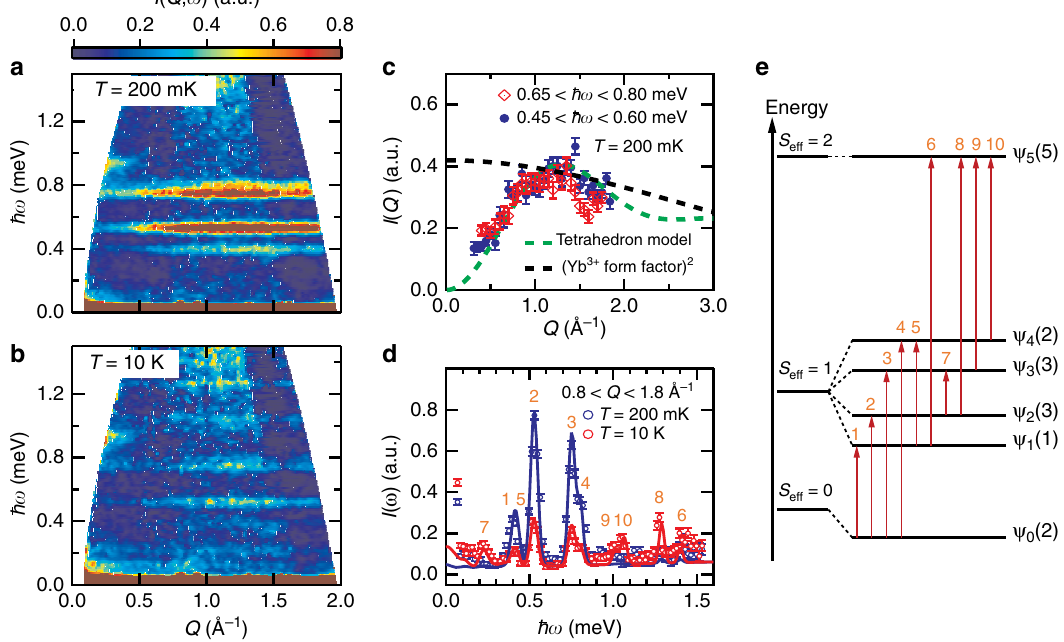
Figure 2 | INS results and an energy diagram of a Yb 4 molecular tetrahedron. ( a , b ) INS intensities I ( Q, o ) as a function of momentum Q and energy transfer : o measured using incident neutron energy E ¼ 2.27meV ( ¼ 6.0Å) at ( a ) T ¼ 200mK and ( b ) T ¼ 10K. ( c ) Constant- o cuts I ( Q )’s obtained by integrating over ranges of 0.45meV o : o o 0.60meV (blue filled circle) and 0.65meV o : o o 0.80meV (diamond) at 200mK. A black dashed line represents the square of the Yb 3 þ magnetic form factor, and a green dashed line does the model calcution for a Yb 4 tetrahedron, which expresses a functional form of 1 (cid:2) sin( Qr )/ Qr at r ¼ 3.30Å. ( d ) Constant- Q cuts I ( o )’s obtained by integrating over a range of 0.8Å (cid:2) 1 o Q o 1.8Å (cid:2) 1 at T ¼ 200mK (blue circle) and T ¼ 10K (red circle). Solid lines present simulated I ( o )’s from the effective Hamiltonian H eff . ( e ) Schematic energy level diagram extracted from diagonalization of H eff . The degeneracy of each energy level is presented in the paranthesis together with the eigenstate c . The excitations with indices from 1 to 10 (vertical red arrows) are observable in I ( o )’s in d . Intensity error bars are square roots of